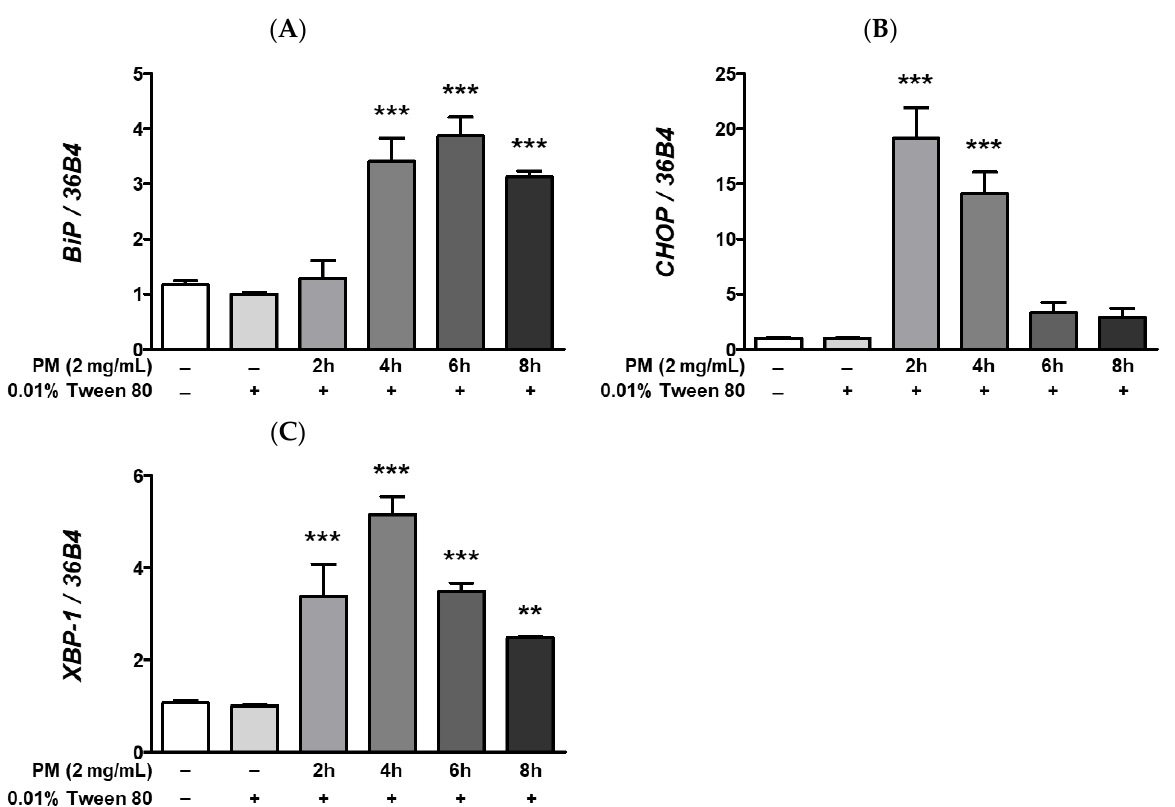
Figure 5. Effect of PM on UPR-related mRNAs expression in ARPE-19 cells. Cells were treated with 2 mg/mL of PM for 0–8 h. An amount of 0.01% Tween-80 was used as a vehicle control. The mRNA levels of ( A ) BiP , ( B ) CHOP , and ( C ) XBP-1 were measured by qRT-PCR, using 36B4 as the reference gene for normalization. Data are shown as mean ± SD ( n = 3). Data were analyzed using one-way ANOVA followed by Tukey’s multiple comparison (** p < 0.01, *** p < 0.001). All comparisons were made to the vehicle control group. Abbreviations used in Figure: PM; particulate matter, BiP; binding of immunoglobulin protein, CHOP; CCAAT/enhancer-binding protein homologous protein, XBP-1; X-box binding protein 1 .